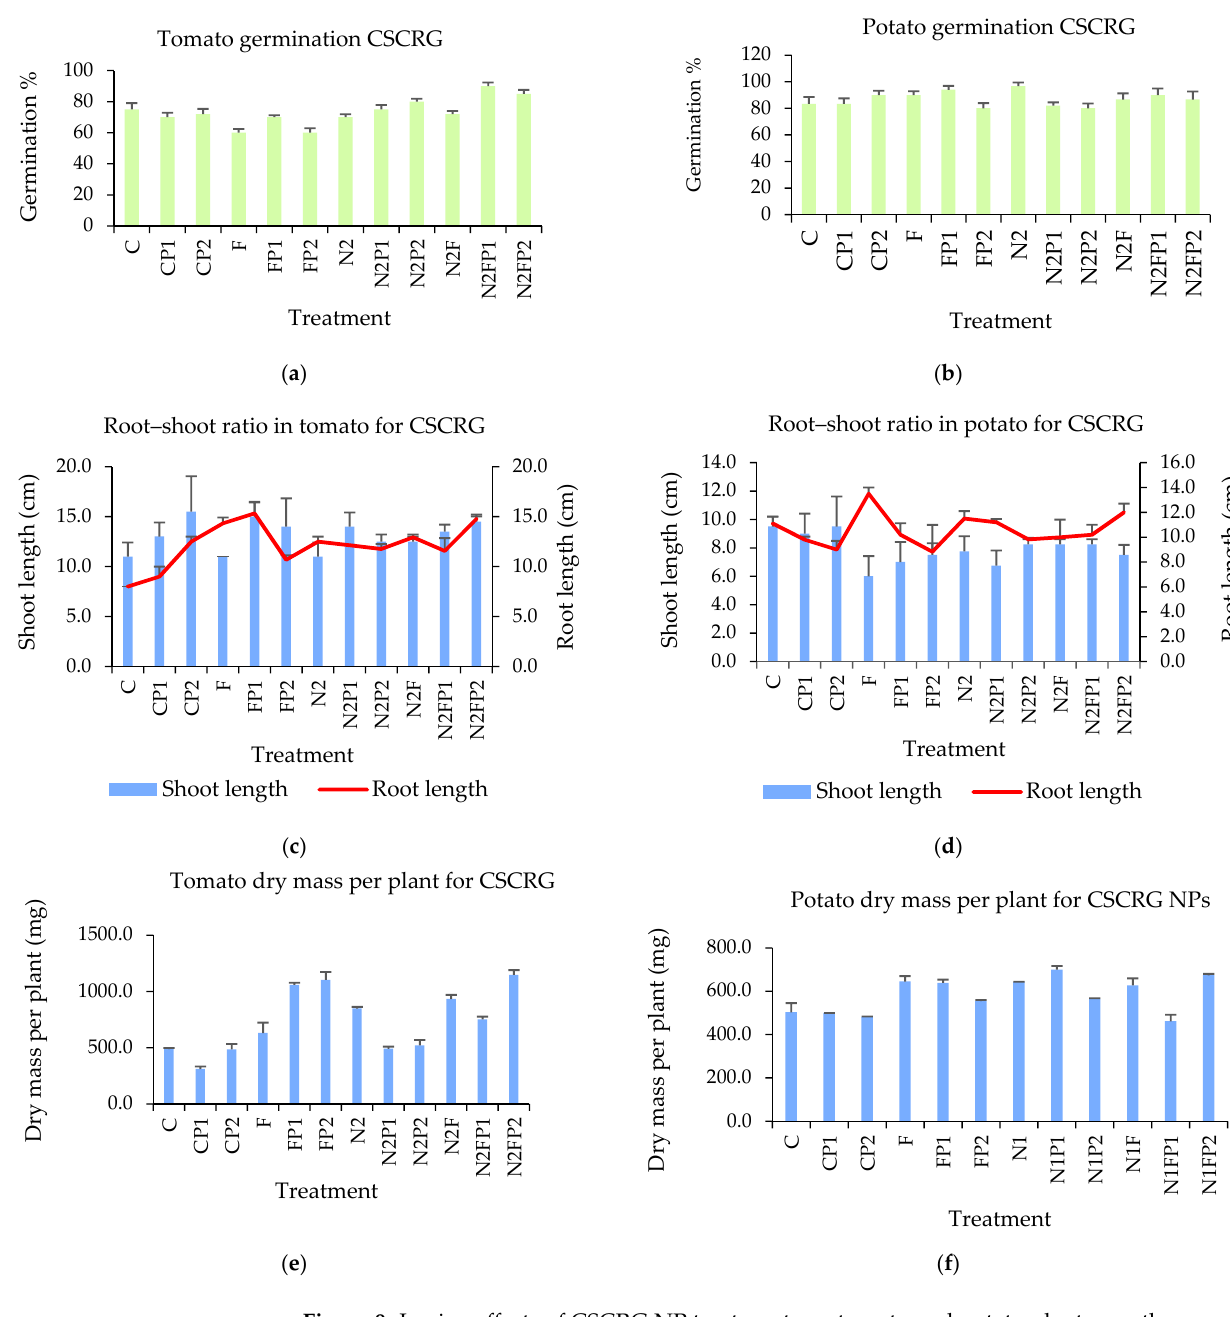
Figure 9. In vivo effects of CSCRG NP treatments on tomato and potato plant growth parameters: ( a , b ) germination percentage, ( c , d ) root–shoot ratio and ( e , f ) dry mass per plant. C—control (No treatment), CP1—plants made sick with pathogen P1, F—plants treated with commercial fungicide, FP1—plants made sick with the pathogen and treated with commercial fungicide, N1—blank NP treatment, N1P1—plants made sick with pathogen and treated with blank NPs, N1F—plants treated with fungicide-loaded NPs, N1FP1—plants made sick with pathogens and treated with fungicide loaded NPs, CP2—plants made sick with pathogen P2, FP2—fungicide-treated plants made sick with pathogen P2, N1P2—plants made sick with pathogen P2 and treated with blank NPs , N1FP2— plants made sick with pathogen P2 and treated with fungicide loaded NPs . For tomato: Pathogen P1 = A. alternata , P2 = S. lycopersici ; for potato: Pathogen P1 = A. solani , P2 = Sclerotinia sclerotiorum.